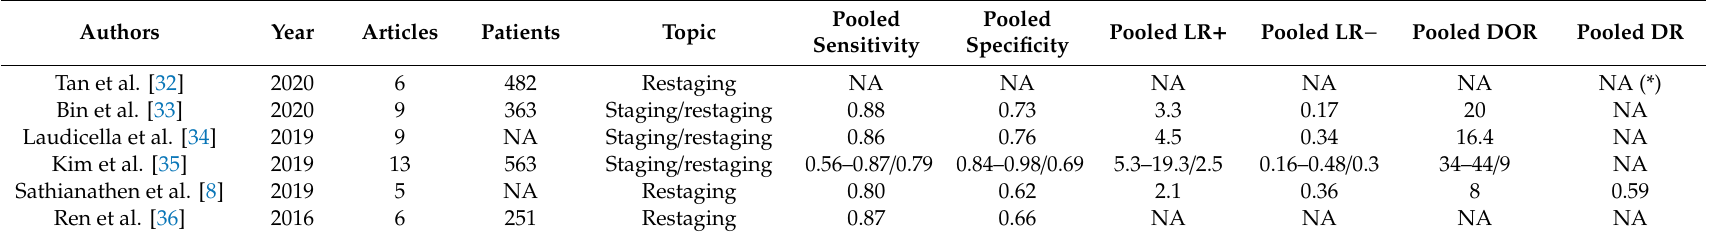
Table 3. Meta-analyses on radiolabeled fluciclovine (FACBC) PET / CT in prostate